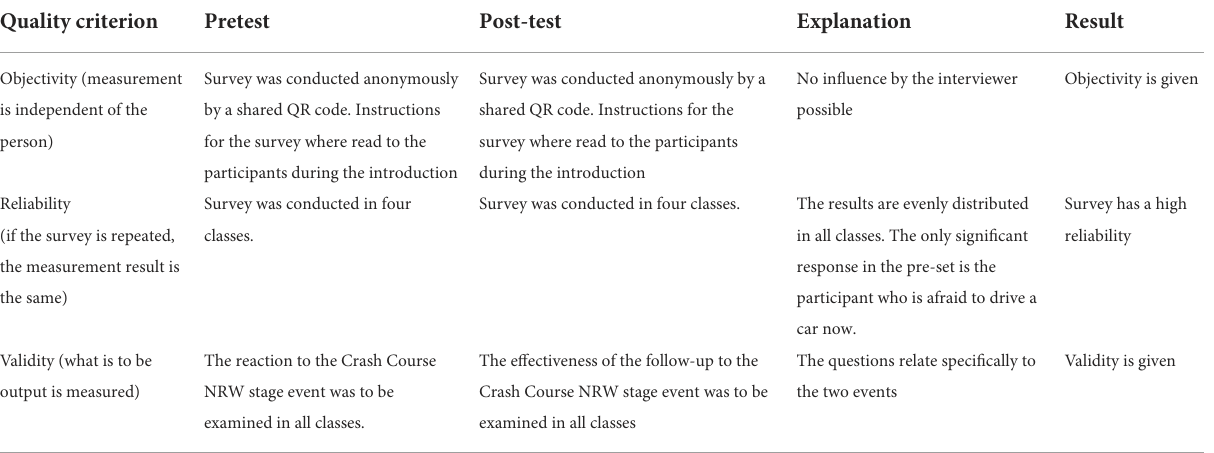
TABLE 4 Overview of the quality criteria of the preliminary test and post-test. Quality